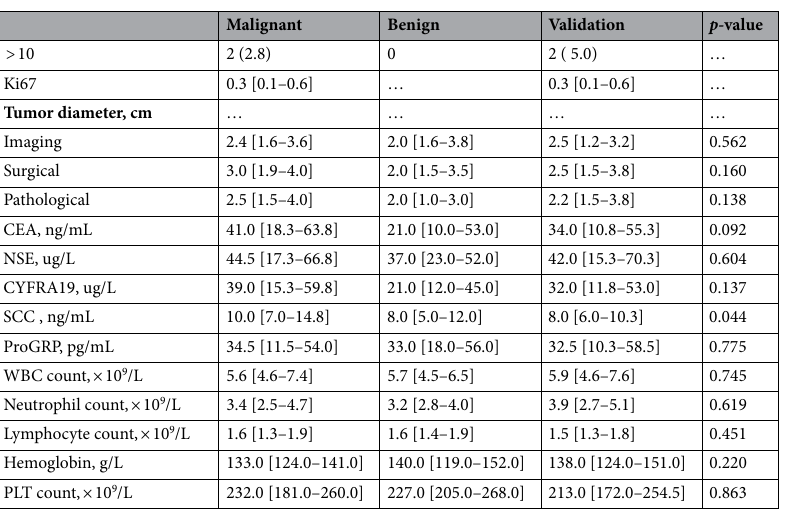
Table 1. Clinical characteristics and laboratory findings. CEA carcinoembryonic antigen; CPS carbamoyl- phosphate synthase 1; CYFRA19 cytokeratin fragment 19; NSE neutron-specific enolase; PLT platelet count; ProGRP progastrin-releasing peptide; SCC squamous cell carcinoma; TIL tumor infiltrating leukocyte; WBC white blood